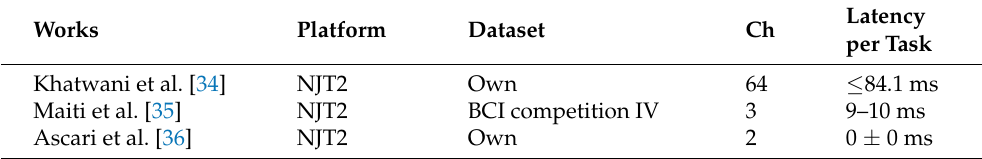
Table 1. The state-of-the-art summary of related works. Ch means the number of channels. Works